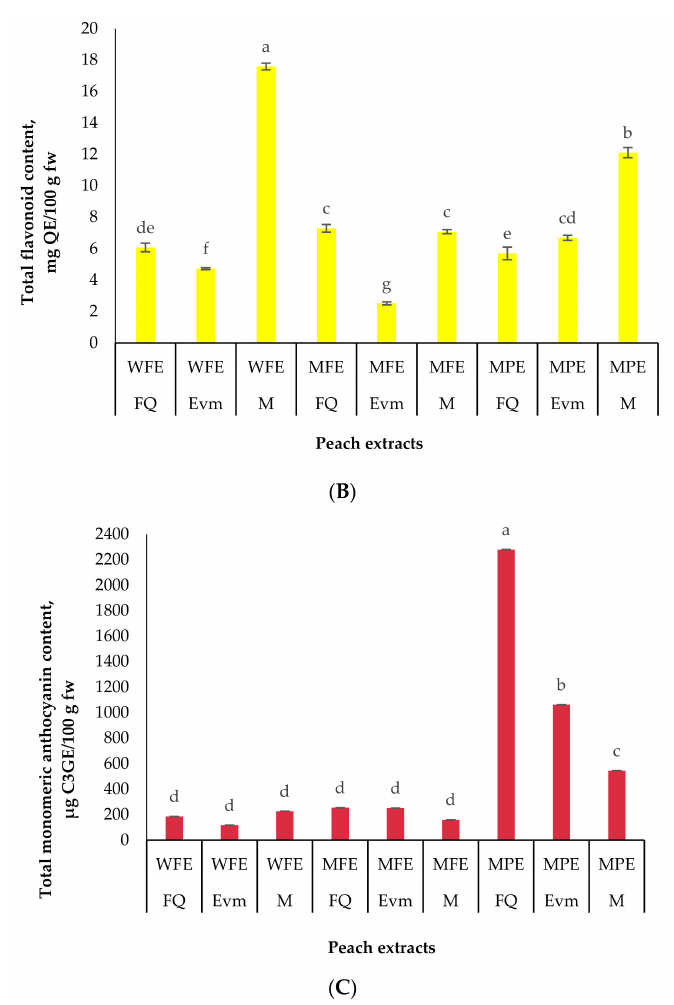
Figure 2. Total phenolic content (mg GAE/100 g fw) ( A ), total flavonoids (mgQE/100 g fw) ( B ) and total monomeric anthocyanins ( µ g cyanidin-3-glucoside (C3GE)/100 g fw) ( C ) of late season peach ( Prunus persica L.) varieties. Values are means, n = 3 per treatment group. Different letters (a-g) within chart columns indicate significant differences ( p < 0.05) between treatments as analyzed by two-way ANOVA and the Tukey test. The p -value for each treatment group (variety or extract), and